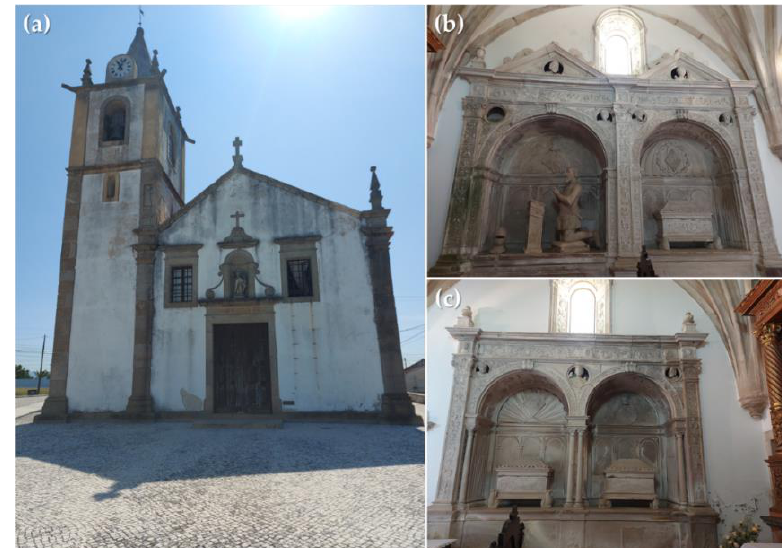
Figure 1. Study site ( a ) Church of Trofa do Vouga which houses the Lemos Pantheon. ( b ) Left side of the Pantheon comprising the tombs of D. Joana de Melo (on the right) and her husband, D. Duarte de Lemos (on the left), where the praying statue stands ( c ) Right side of the Pantheon comprising the tombs of Gomes Martins de Lemos and his son, João Gomes de Lemos (on the right), and their